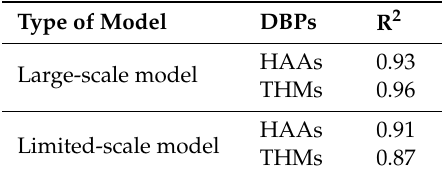
Table4. R 2 valuesfrommodelsforDBPlevelsestimationfromDUVAwiththelaboratoryspectrophotometer.